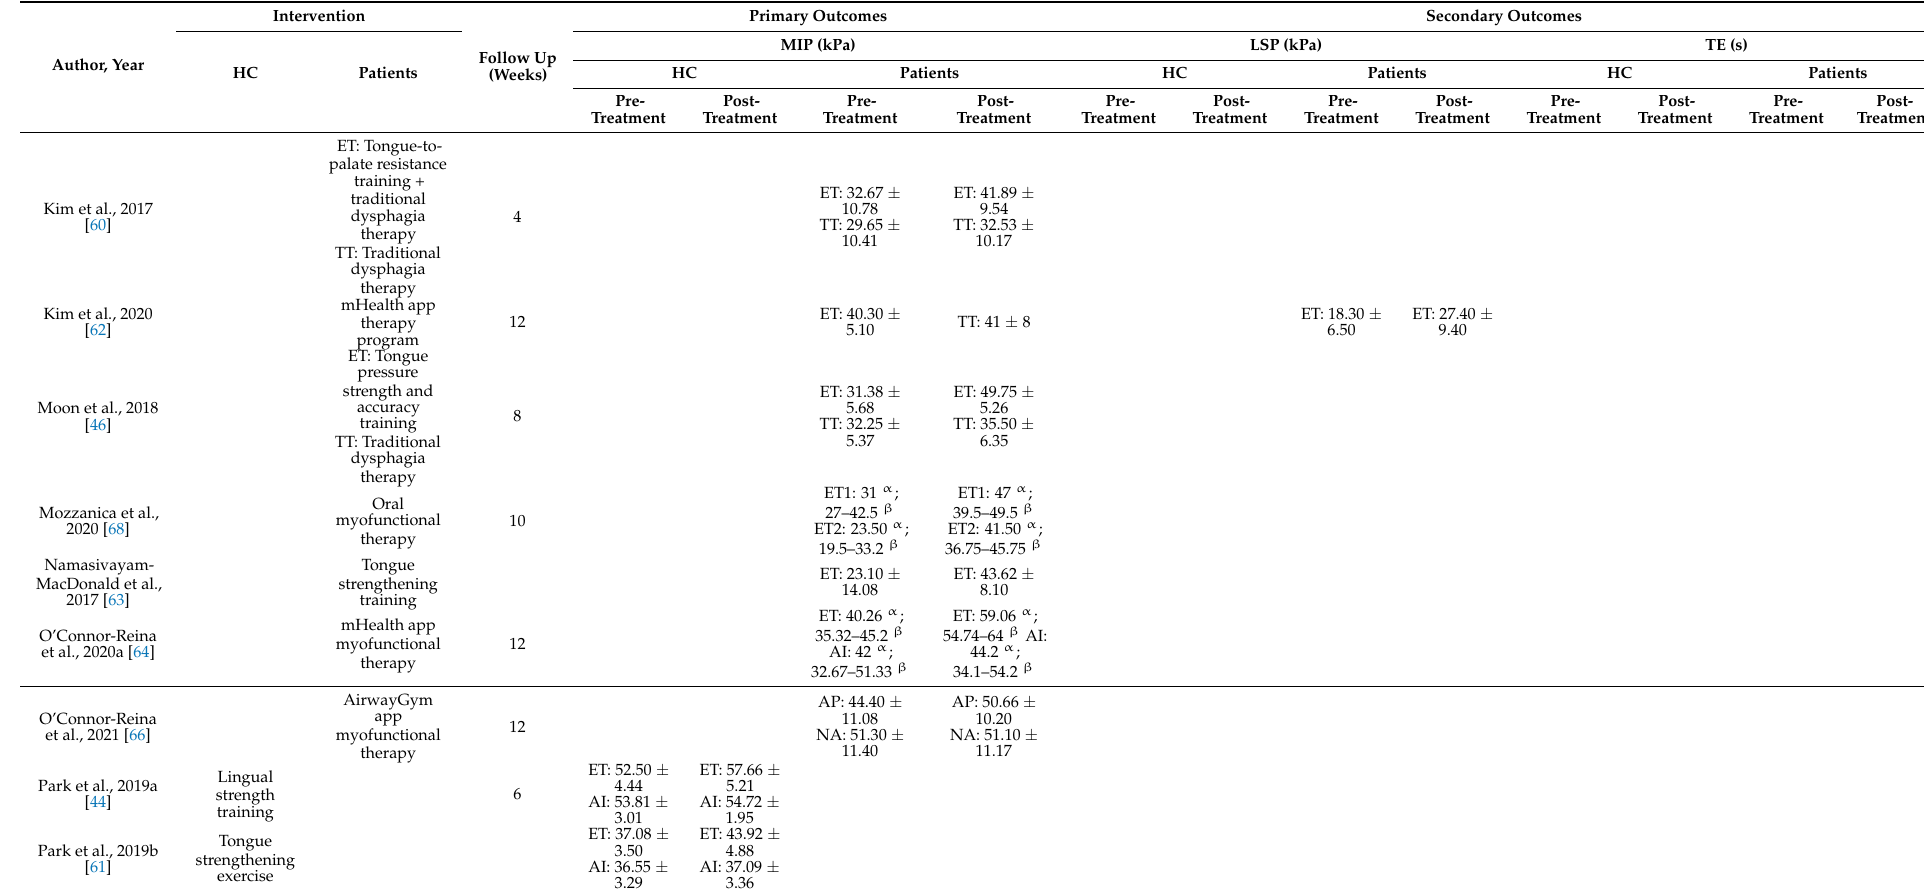
Table 7. IOPI measures for the intervention